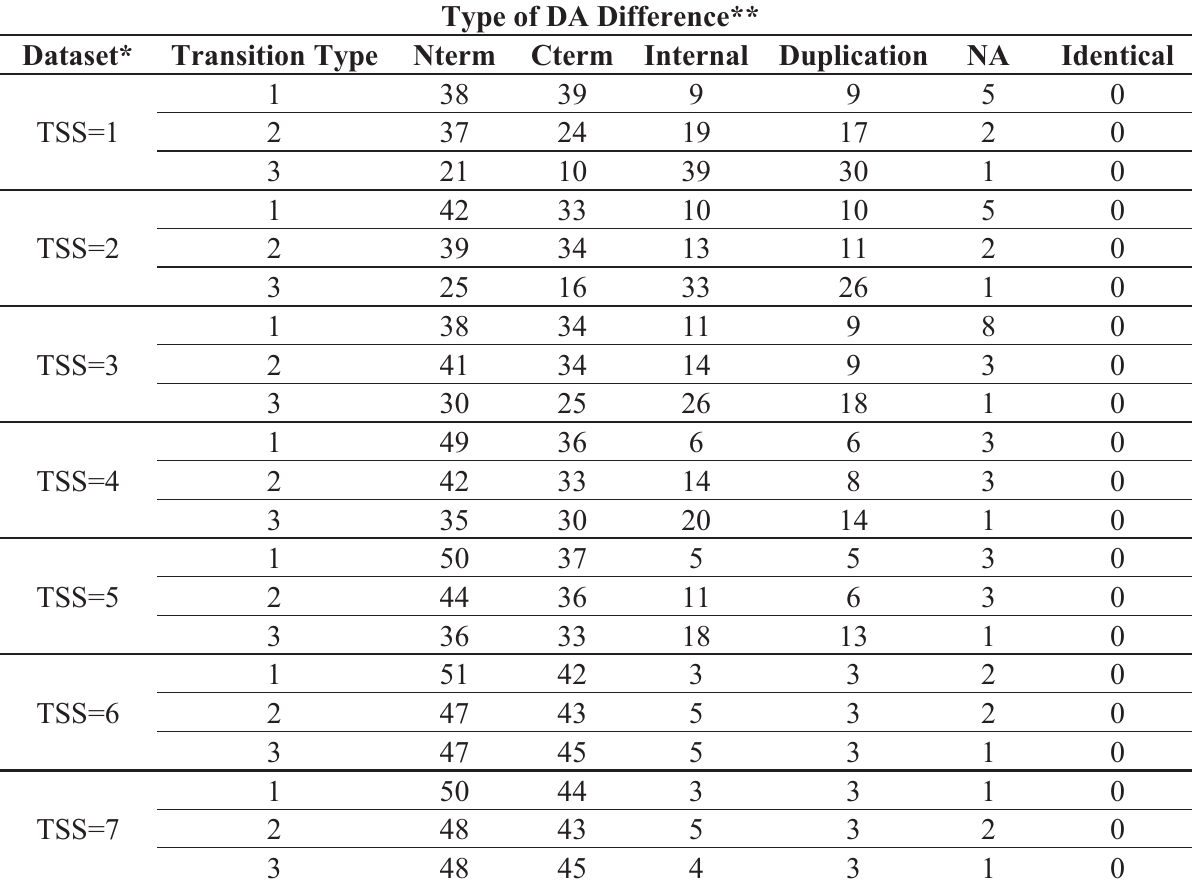
Table S6. Positional distribution of DA differences of paralogous human Swiss-Prot proteins defined through intraspecies comparisons.